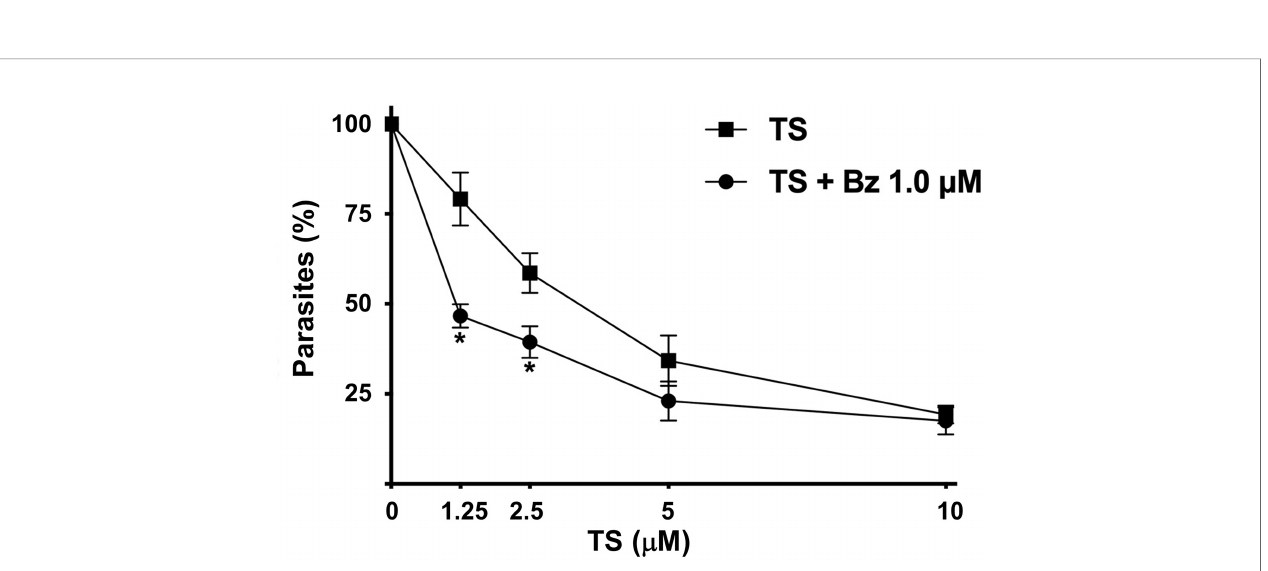
FIGURE 6 | Synergic effect of TS and Bz. Cell-derived trypomastigotes were incubated in the presence of different concentrations of TS alone or in combination with 1.0 m M Bz. Parasite number was established by counting in a Neubauer chamber after 24 h of drugs incubation. The results are presented as media ± standard deviation. Statistically signi fi cant differences are indicated with an asterisk (p < 0.001).